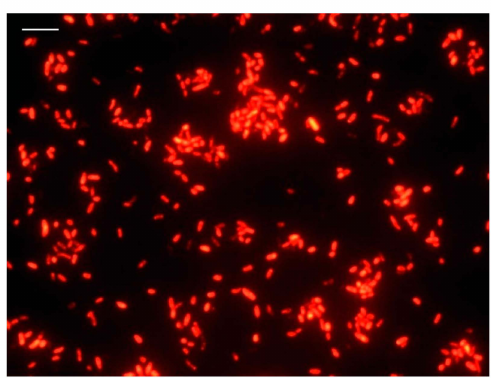
Figure 1. FISH micrographs showing the hybridization of V. parahaemolyticus cells, showing the usual cell size as the control. (bar: 10 µ